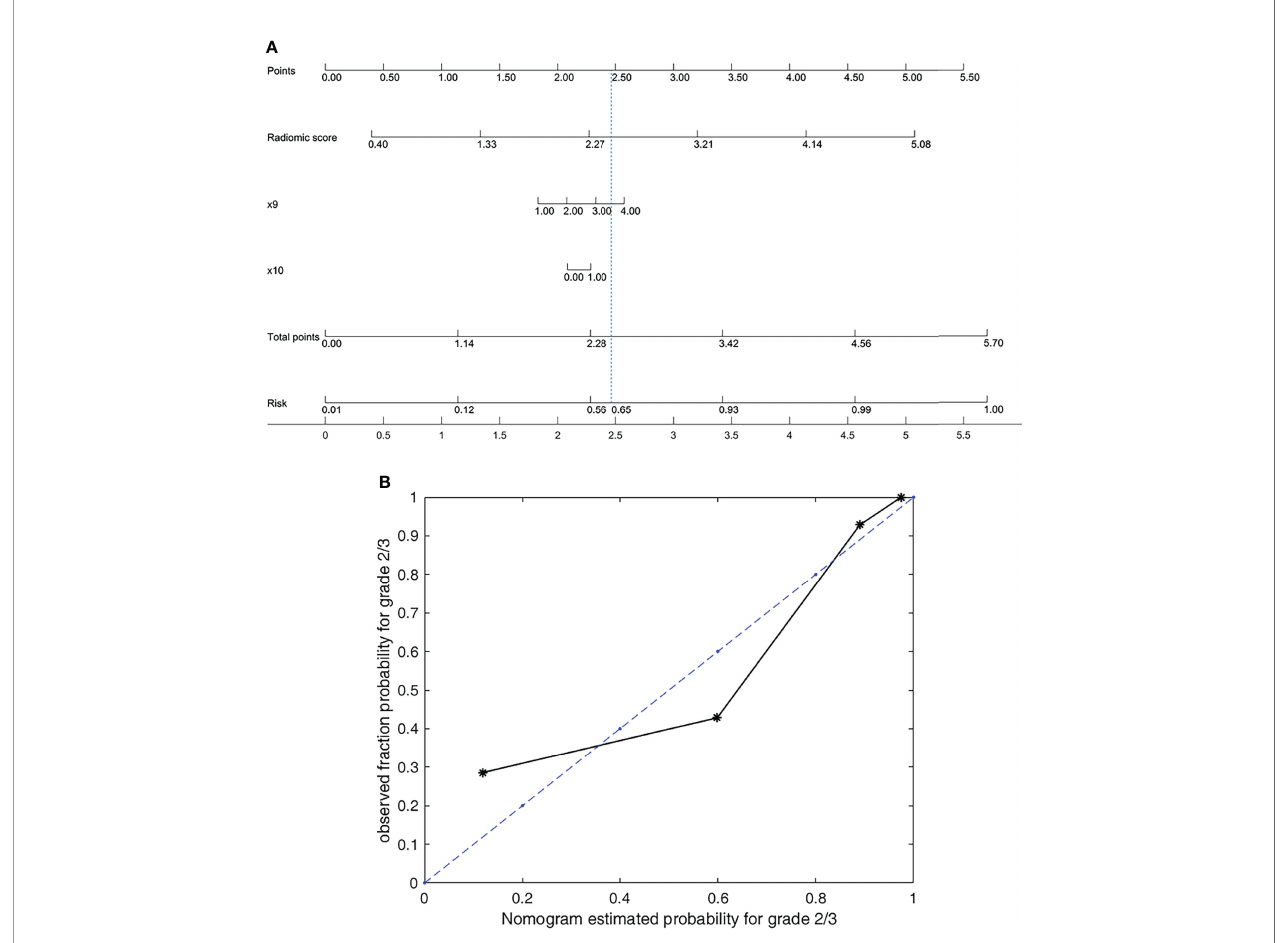
FIGURE 3 | Nomogram and its calibration curve based on group 2 for predicting grade 2/3. (A) Nomogram for group 2. (B) Calibration curve, where the diagonal dotted line is a perfect estimation by an ideal model. The predicted (estimated) probabilities of the validation set were sorted and divided into four groups based on quartiles to calculate the observed true probabilities. We calculated the goodness of fi t to evaluate how well the solid line fi ts the dotted line. The goodness of fi t is 0.8683, which indicates that the two lines fi t